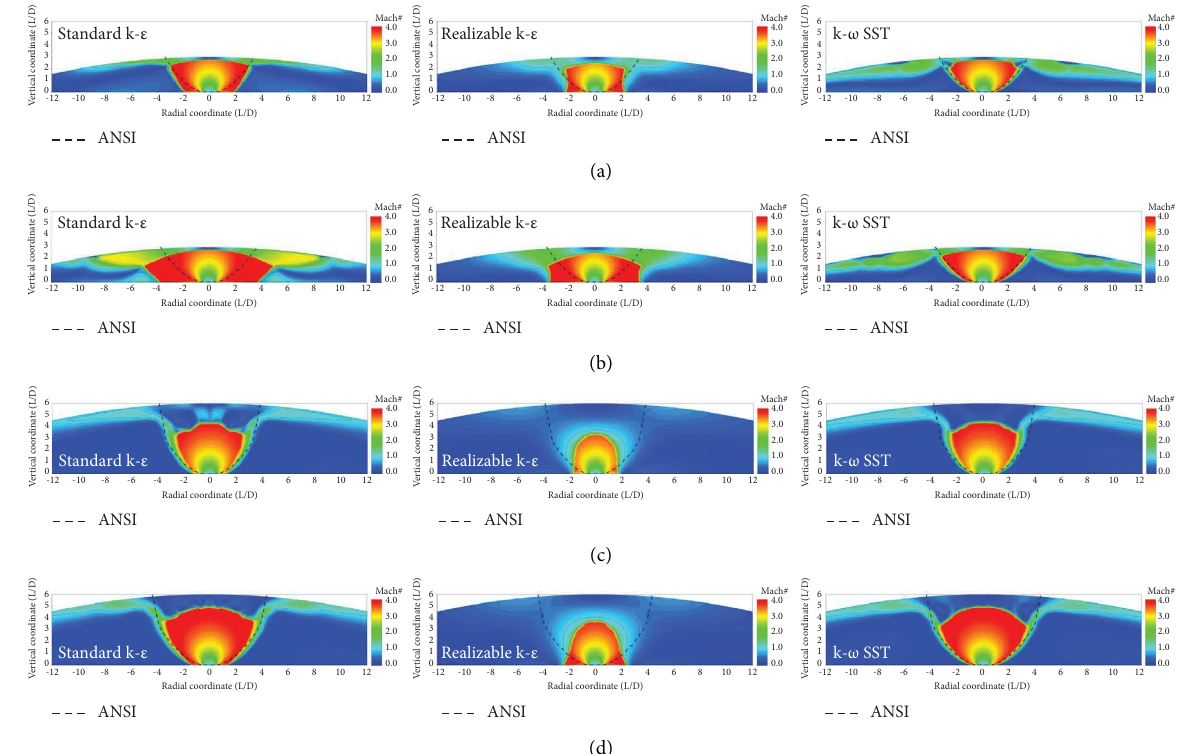
Figure 9: Distribution of the Mach number on the side-view: (a) gap: 3mm, P P 0 � 70 bar, and (d) gap: 6mm, P 0 �